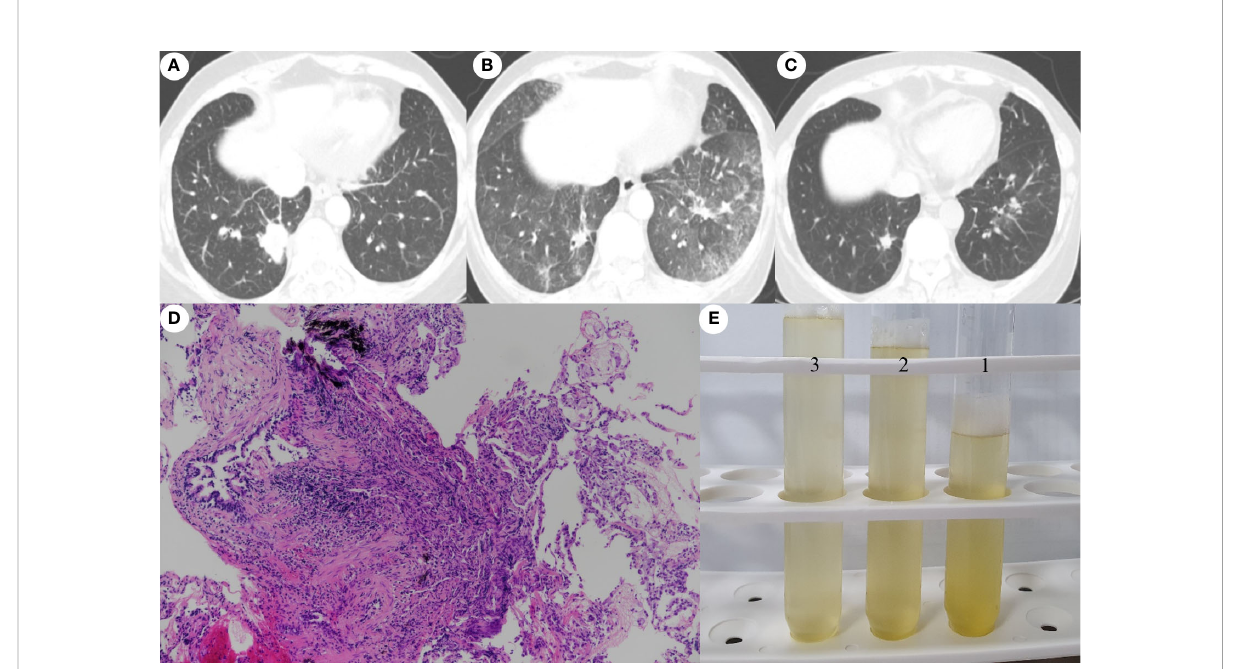
FIGURE 1 Chest computed tomography images showing. (A) A lobulated mass with pleural retraction in the posterobasal segment of the right lower lobe (RLL) and multiple tiny nodules in both lungs at the time of diagnosis. (B) Four months after initiating crizotinib, bilateral ground-glass opacities were observed, despite an obvious decrease in the size of the primary tumor in the RLL and multiple nodules in both lungs. (C) Nine weeks after crizotinib retreatment, a further decrease in the size of the primary RLL tumor and almost complete clearing of the bilateral ground-glass opacities was seen, without recurrence of ILD. (D) Transbronchial lung biopsy specimen showing patchy lymphocytic in fi ltration of the peribronchiolar interstitium and intra-alveolar accumulation of foamy macrophages (hematoxylin-eosin stain, x100). (E) Photograph of the non- diagnostic, yellowish fl uid aspirated through bonchoalveolar